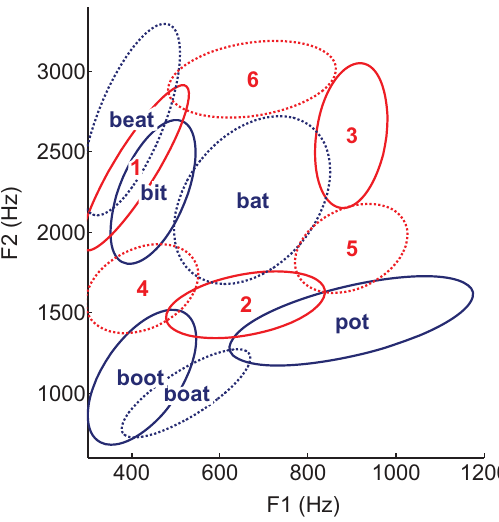
Figure 2. Categorical (red) and non-categorical (dark blue) vowel targets are shown by their designated ellipses in the formant (F1–F2) plane. Categorical vowels were assigned exemplar words that were shown in the center of the ellipse or center of the screen for the established categories text cue (EC-AT) group, depending on the session, to cue the participant which vowel sound to produce. Solid ellipses designate the vowel targets trained and tested in the first three sessions, while the dashed ellipses designate novel (untrained) vowel targets participants had to generalize to in the final (fourth)